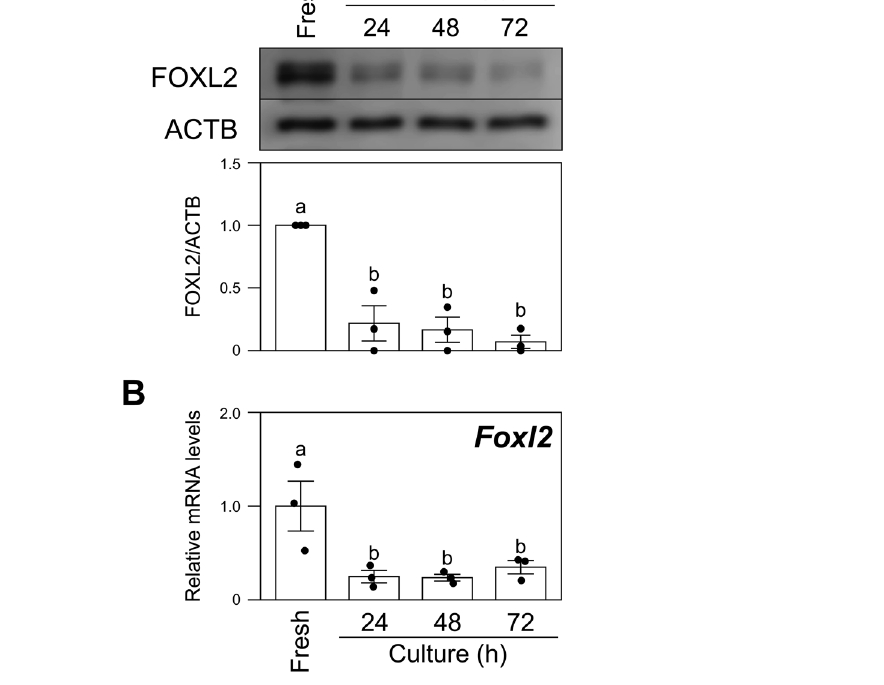
Figure 1. Effects of culture on the expression kinetics of FOXL2 in MGCs. Freshly isolated MGCs (Fresh) and MGCs cultured for 24, 48, and 72 h were examined. ( A ) The expression levels of FOXL2 protein were examined by western blotting (upper panel). The relative intensities of protein bands were quantified (lower panel) (n = 3). ( B ) The expression levels of Foxl2 mRNA were examined by qPCR (n = 3). Different letters (a and b) denote significant differences (p <